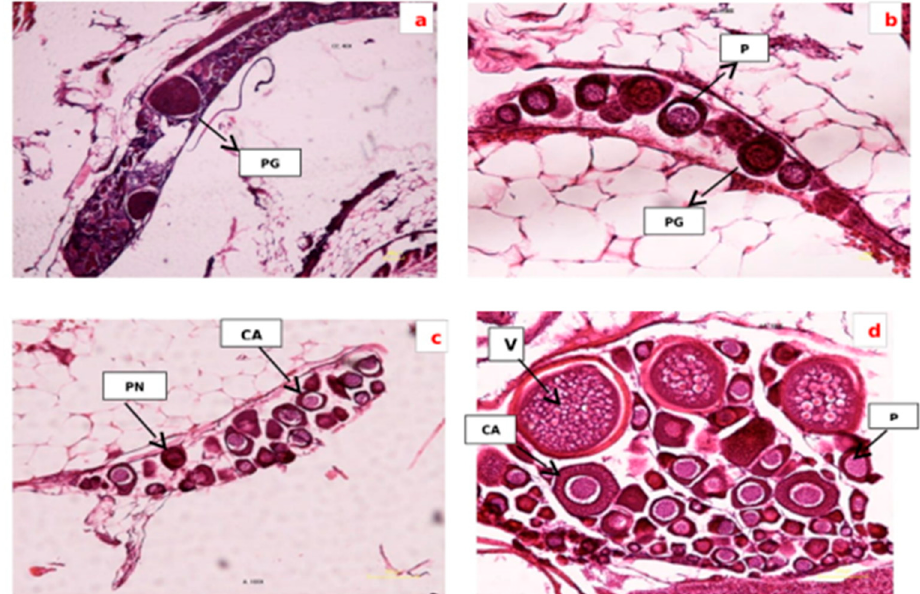
Figure 1. Section of ovarian tissue in different groups: ( a ) control group. Egg is in primary growth stage (PG); ( b ) treated by Vitex agnus-castus at dose 5 g/1 kg, the oocytes are in primary growth stage (PG) and perinucleoar stage (PN); ( c ) treated by Vitex agnus-castus at dose 10 g/1 kg, dominant phase oocytes contain cortical alveolar stage (CA); ( d ) treated by Vitex agnus-castus at dose 15 g/1 kg, the vitellogenin stage is apparent (GV), (100 μ m, HandE).